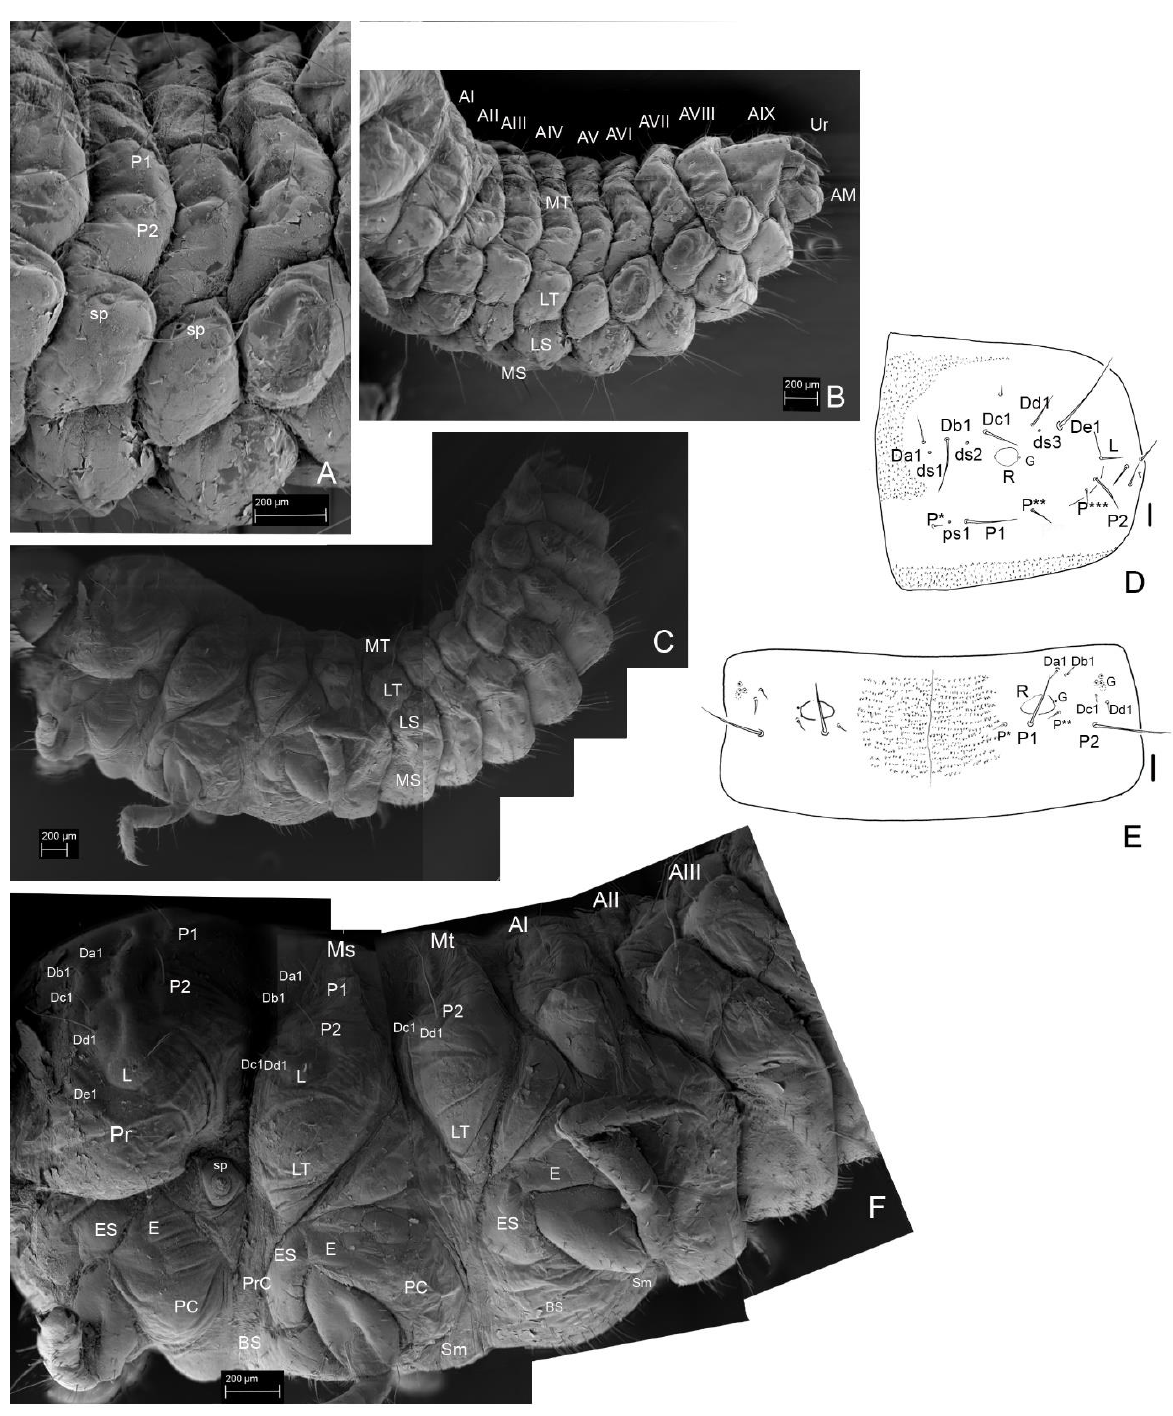
Figure 14. Leiodes cinnamomea. Details of larval morphology of instar III. ( A ) Abdominal tergites and laterotergites III–VI. ( B ) Abdominal tergites and laterotergites I–IX. ( C ) Thorax and abdomen, lateral view. ( D ) Pronotum—scheme of chaetotaxy. ( E ) Abdominal tergite—scheme of chaetotaxy. ( F ) Thorax and abdominal segments I–II, lateral view. Abbreviations: AI–IX—abdominal segments I–